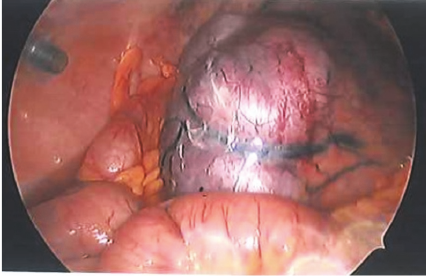
Figure 2: Laparoscopic view of infarcted